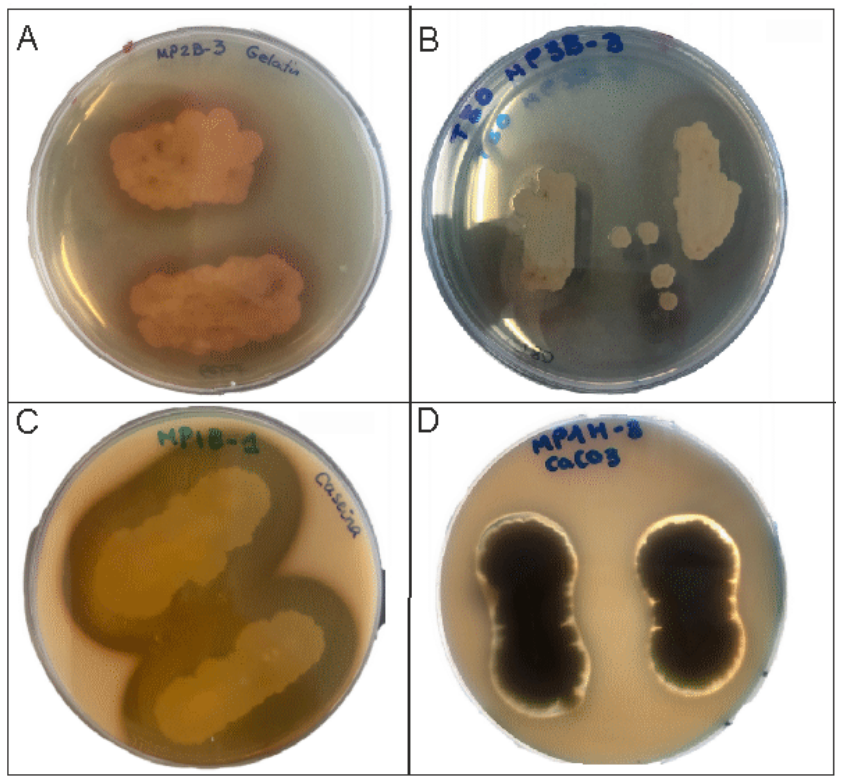
Figure 3. Metabolic activities of isolates. ( A ) Gelatin hydrolysis by Bacillus paralicheniformis . ( B ) Lipolytic activity by Priestia endophytica . ( C ) Casein hydrolysis by Priestia aryabhattai . ( D ) Calcite solubilization by Penicillium fuscoglaucum .